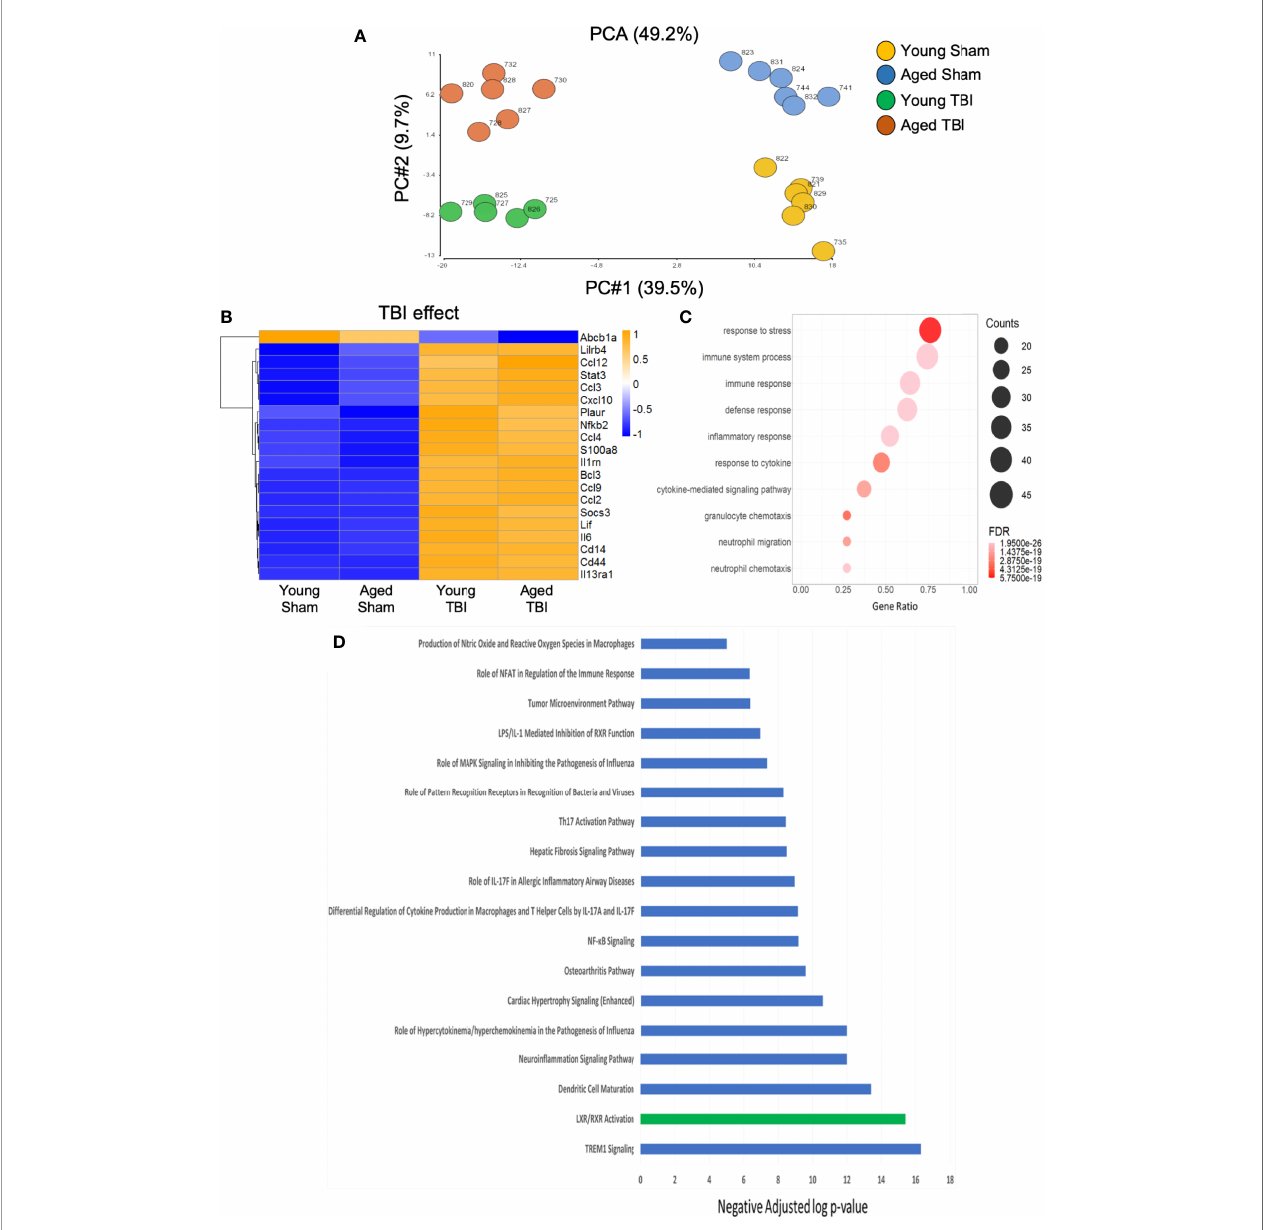
FIGURE 2 | In fl ammatory gene expression in injured cortex is primarily altered by TBI. NanoString analysis using a mouse Immunology panel was used to assess cortical transcriptional patterns at 24 hours post-injury in young sham, aged sham, young TBI, and aged TBI mice (n=6/group). (A) A principle components analysis of all transcripts by subject identi fi es key genes changed by TBI (PC1) and age (PC2). There was no overlap and minimal within group variability in this analysis. (B) Expression map of the top 20 transcripts that were signi fi cantly altered by TBI only. The heat map color scale re fl ects normalized log-transformed raw counts scaled to z-scores, where -1=darker blue=decreased expression and 1=darker yellow=increased expression. All transcripts that were signi fi cantly altered by TBI only are shown in Supplemental Table 1 . (C) Dot plot of biological function GO terms enriched in the group of transcripts that was signi fi cantly altered by TBI only (R2>0.85), with no signi fi cant covariate effect of AGE. The color of the dots is based on adjusted p-value (FDR) with the darker color (red) corresponding to higher/ greater p-value, and lighter color (violet) corresponding to lower/smaller p values. The radius of the dots is based on the number of genes assigned to the term. The x axis corresponds to the gene ratio, which is the ratio of genes within the dataset represented within a given gene ontology (GO) term and total number of genes assigned the term. There was no secondary thresholding for injury coef fi cients. (D) All transcripts that were signi fi cantly altered by injury (and the respective p-values for injury effect) were analyzed with Ingenuity Pathways Analysis to determine which canonical pathways were represented, and assign a z-score to indicate pathway activation (positive z-score) or deactivation (negative z-score). The top canonical pathways (-log p value of ≥ ≤ 5.0. with z scores >2 or <-2) are represented. All were positive (activated=blue bars), except LXR/RXR which was negatively regulated (deactivated=green bar). Individual z-scores and the genes that contribute to each canonical pathway are shown in Supplemental Table 5